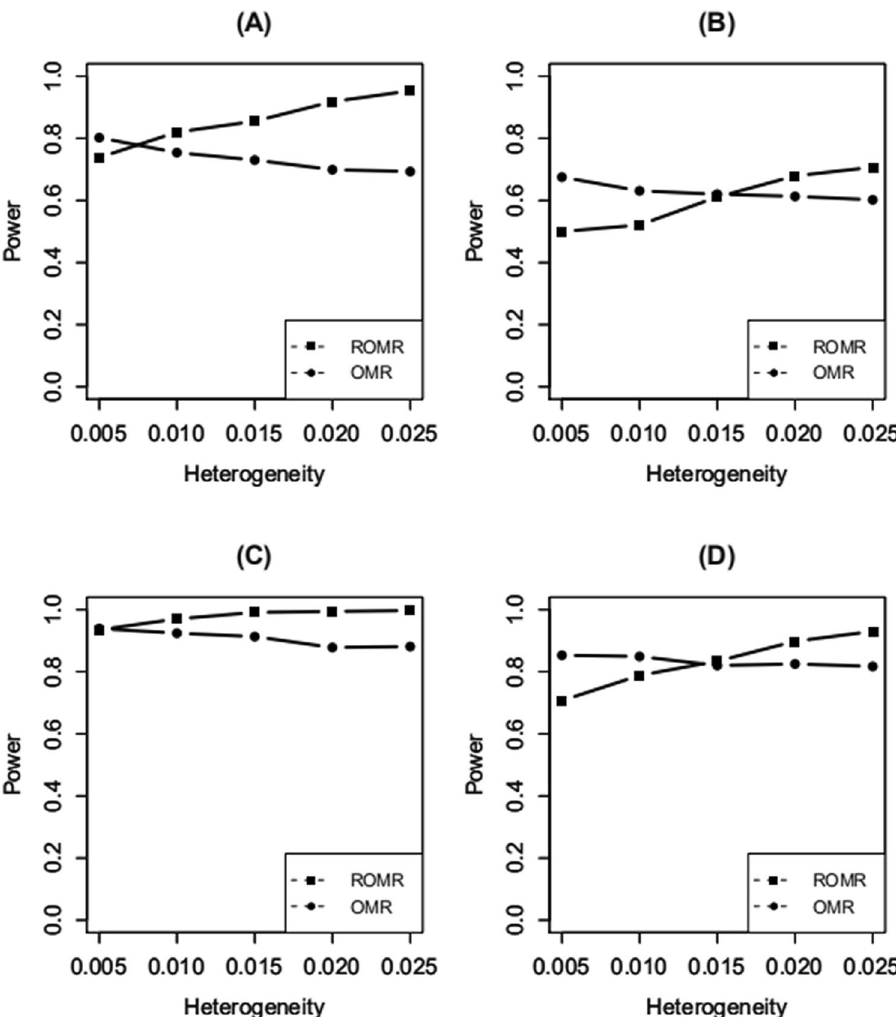
Figure 2. Statistical power of the test for SNP-environment interaction effects and the joint test for SNP and SNP-environment interaction effects. ( A , B ) The tests for SNP-environment interaction effects with 100 and 400 overlapping individuals between any two studies. ( C , D ) The joint tests for SNP and SNP-environment interaction effects with 100 and 400 overlapping individuals between any two studies. The vertical axis is the statistical power, and the horizontal axis is the heterogeneity